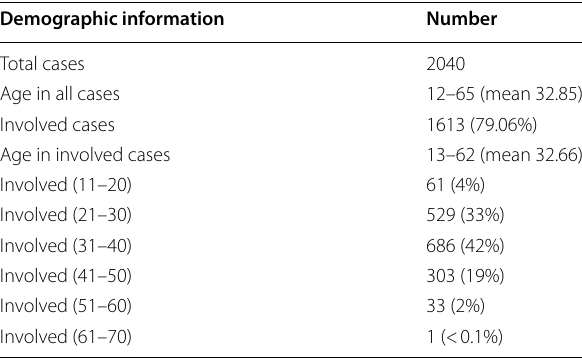
T1 fat-suppressed axial and sagittal protocols are also used for post-contrast-enhanced MRI with the same characteristics